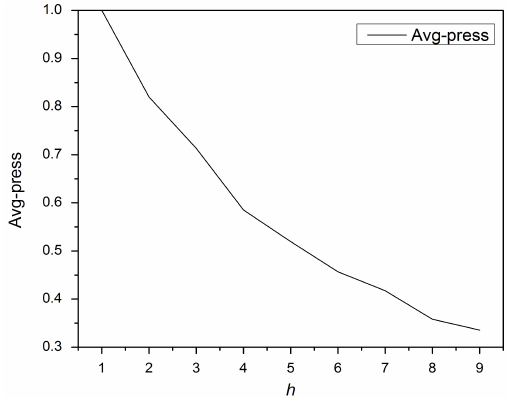
Figure 2. Retrieval evaluation.